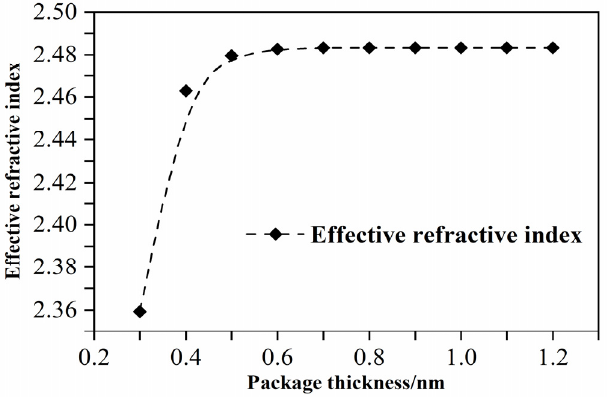
Figure 3. Relationship between different package thicknesses and the effective refractive index.